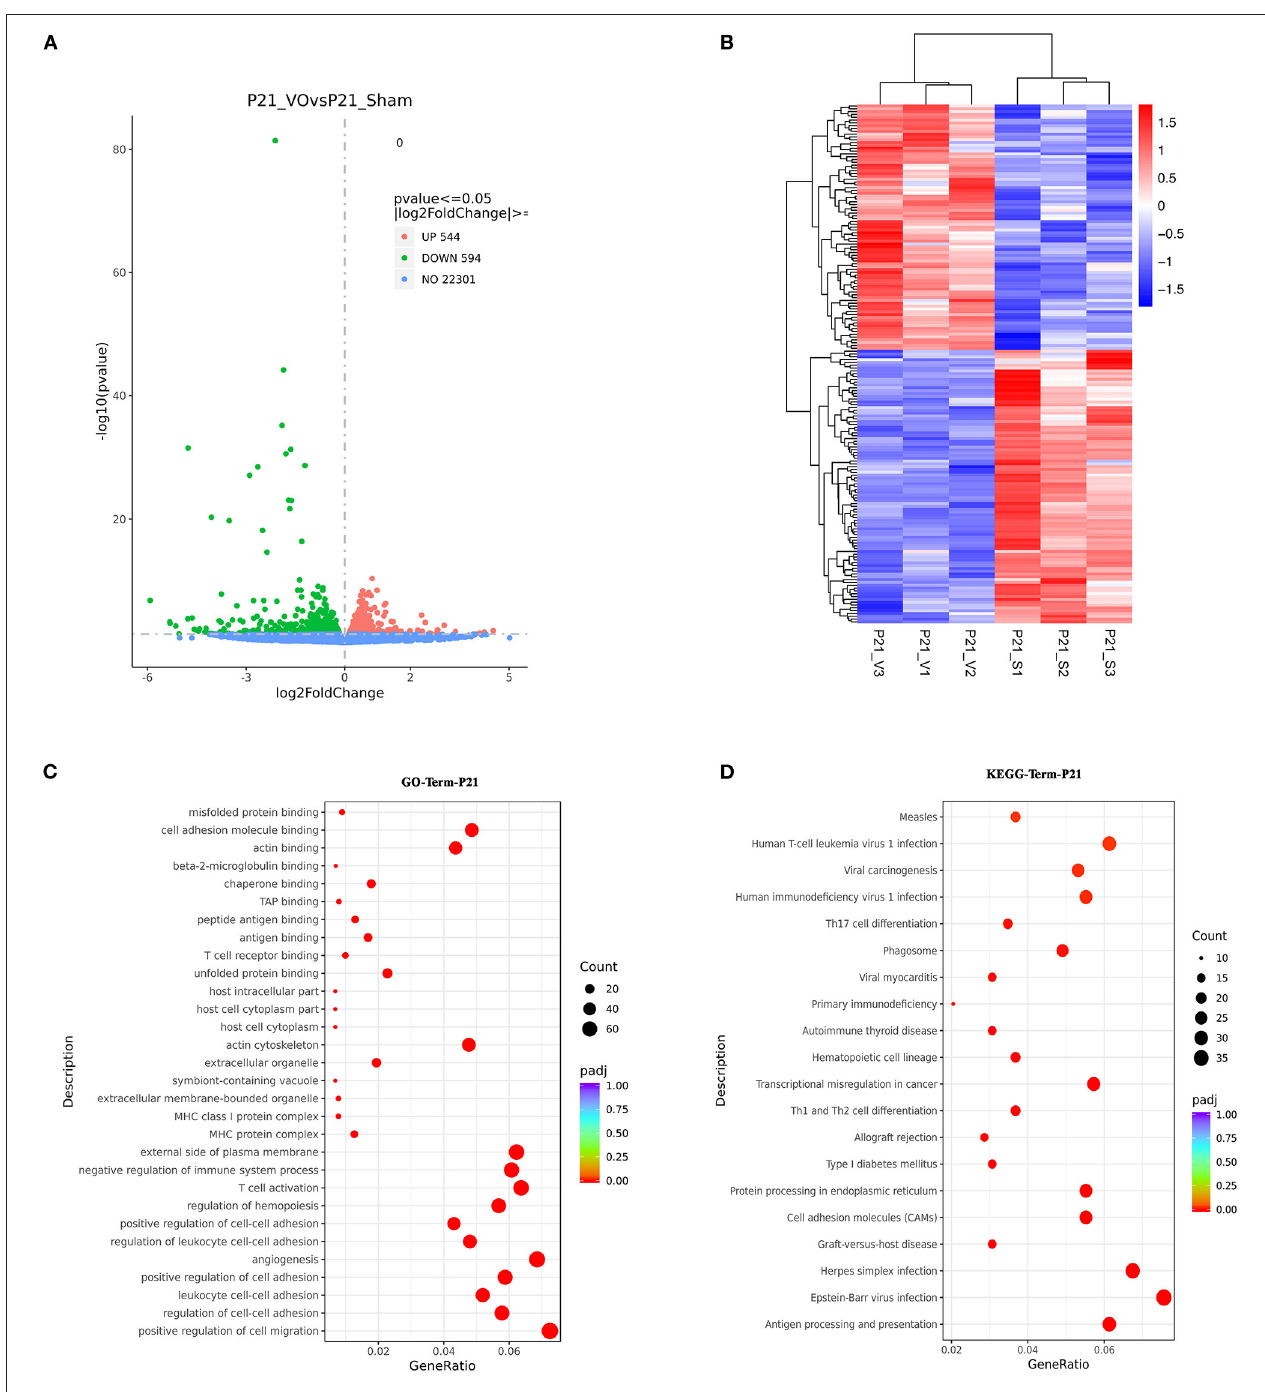
FIGURE 6 | The molecular differences between normal and volume overload (VO)-influenced left ventricles (LVs) at P21. (A) Volcano map of differentially expressed genes (DEGs) between the normal and VO-influenced LVs at P21. (B) Cluster analysis of the DEGs between the normal and VO-influenced LVs. The clusters of genes in each group were quite different from each other but were similar within the same group. (C) Scatter plots of the enriched GO terms. From the results of the GO-enrichment analysis, we selected the 30 most significant terms to construct scatterplots for display. The size of the dots represents the number of genes annotated to the GO term, and the colors from red to purple represent the significance level of the GO term enrichment. (D) Scatterplot of the 20 most significant KEGG pathways. The abscissa is the ratio of the number of genes in the KEGG pathway analysis to the total number of differentially expressed genes, the ordinate is the KEGG pathway, the size of the dots represents the number of genes annotated to the KEGG pathway, and the colors from red to purple represent the significance level of KEGG pathway enrichment.